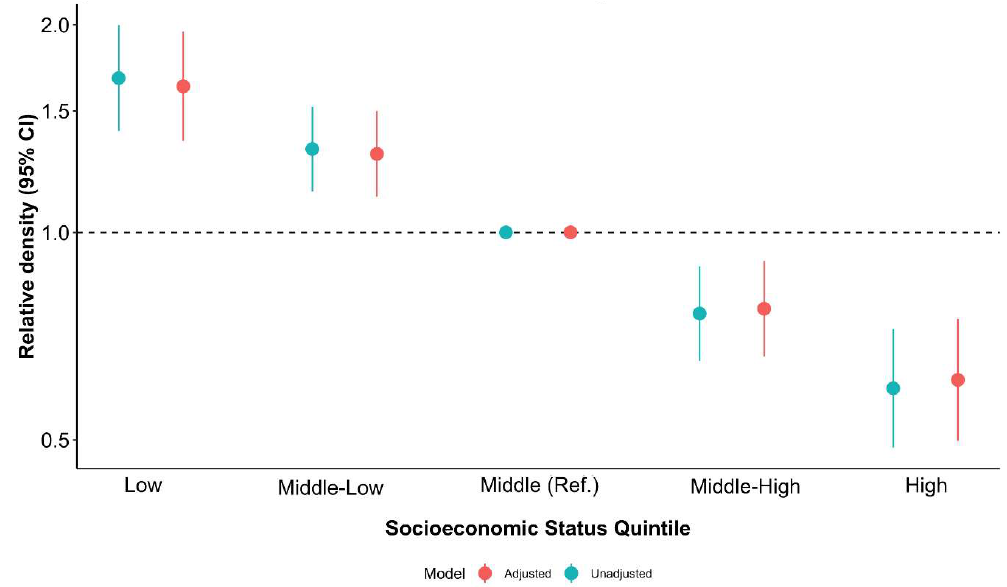
Figure 2. Multilevel negative binomial regression modelling neighborhood-level socioeconomic status with counts of unhealthy outlets around schools in Madrid (2017) before and after adjusting for population density.